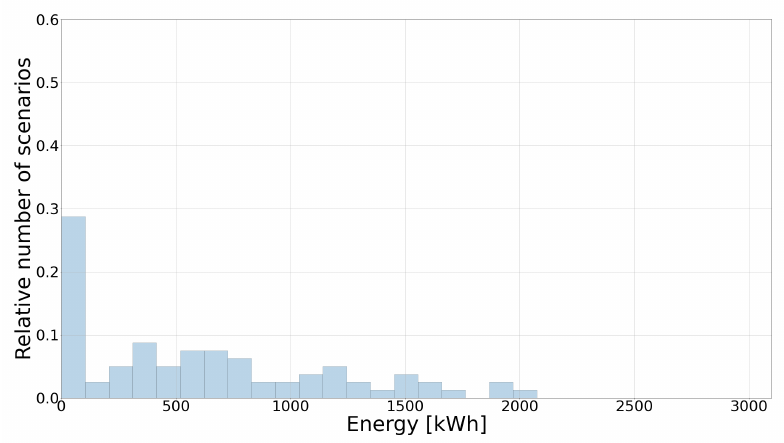
Figure 14. Histogram with PV time series magnitude decreased by 20%.